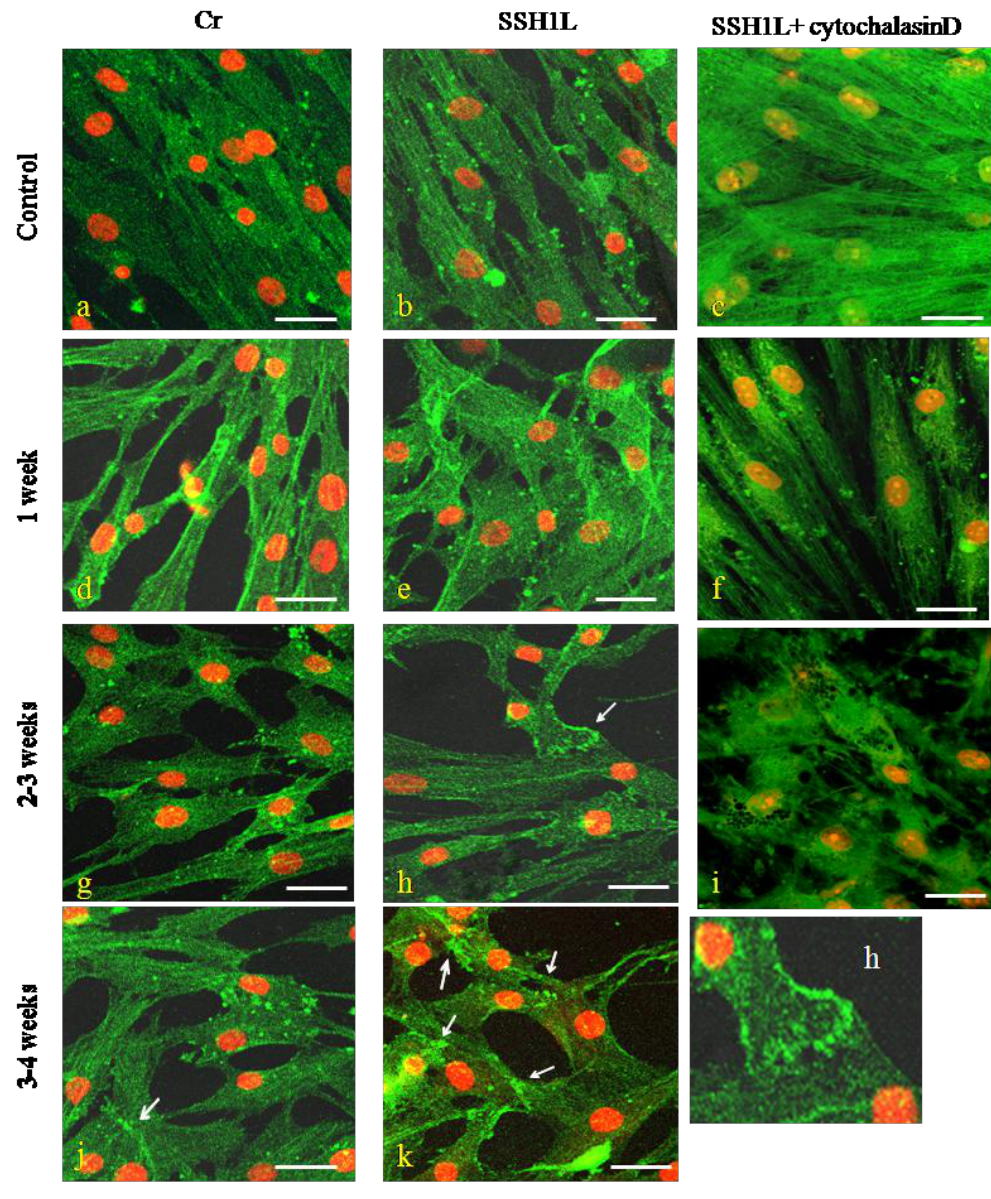
Figure 8. The effect of SSH1L on the changes of microfilament of cardiomyocyte-like cells differentiation induced by 5Aza. The microfilament changes of cardiomyocyte-like cells induced by 5-Aza were photographed under a microscope (bar, 20 μm). In control groups (left panels) the actin microfilaments joined one another forming myotube-like structures; and in SSH group (middle panels) showed actin microfilament junctions forming intercalated disk-like structures; but in cytochalasin D group (right panels) showed no F-actin bundles, only F-actin clumps were visible and cell death constant. microscopy. (h): Arrow indicate the intercalated disk-like structures; (j): Arrow indicate the myotube-like structures; (k): Arrow indicate the myotube-like structures or intercalated disk-like structures. The changes of microfilament were detected by immunofluorescent staining as described under the Experimental. Scale bar, 50